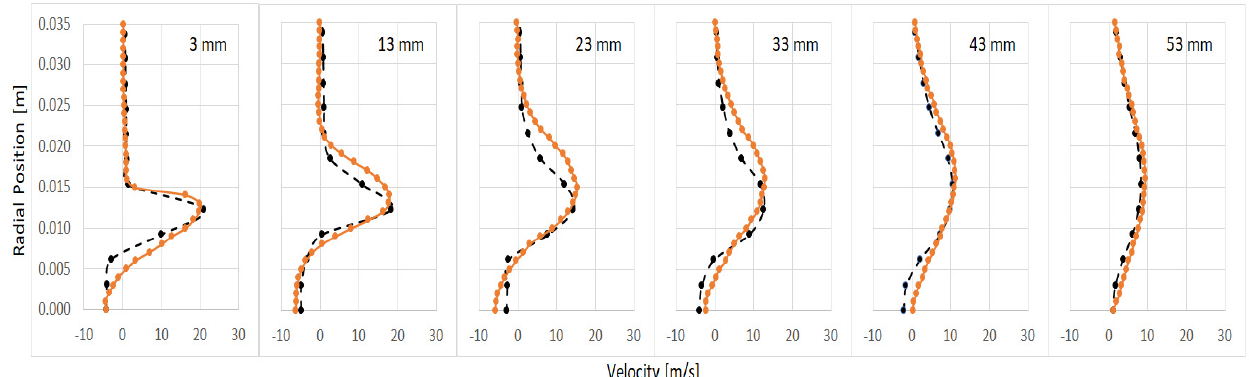
Figure 3. Isothermal results at different axial positions. Experiments (solid, orange line) and numerical (dashed, black line).